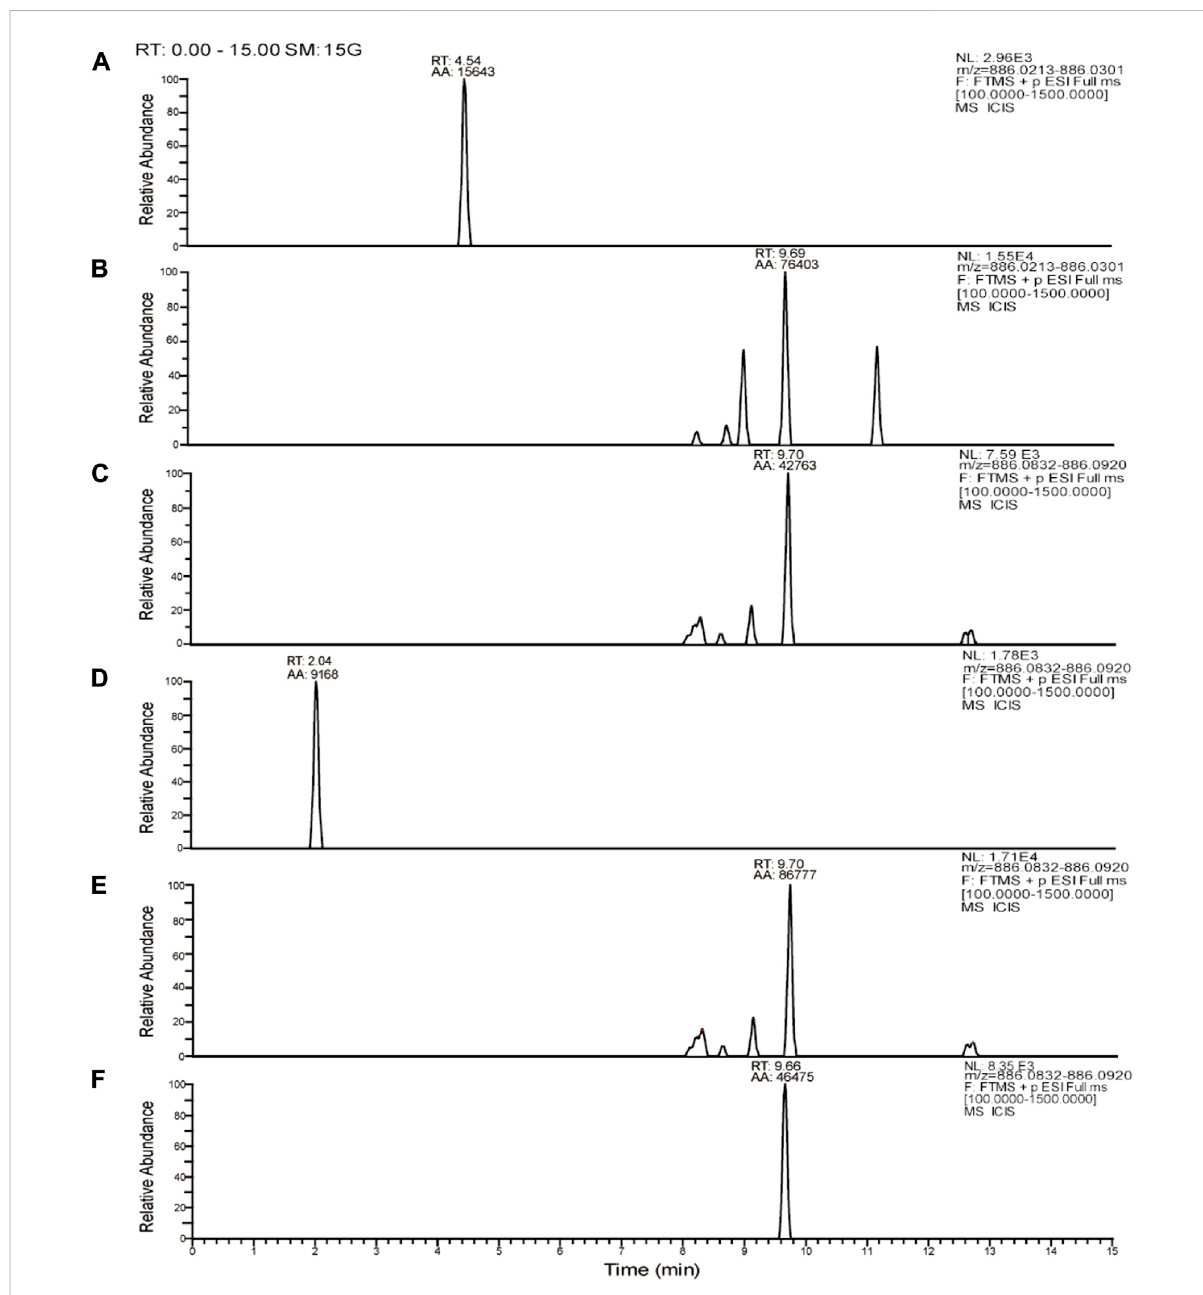
FIGURE 7 Representative extracted ion chromatograms (EICs) of tobramycin derivatization obtained from (A) ATCC27853 broth group (B) ATCC27853 TOB group (C) ATCC27853 DHA27 + TOB group (D) PA16 broth group (E) PA16 TOB group (F) PA16 DHA27 + TOB